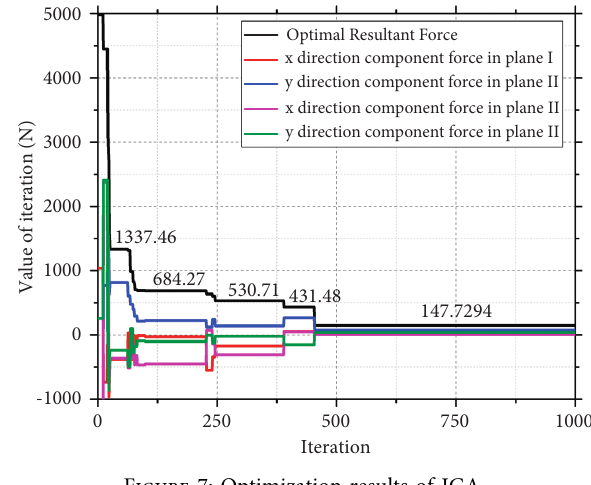
Figure 7: Optimization results of IGA.